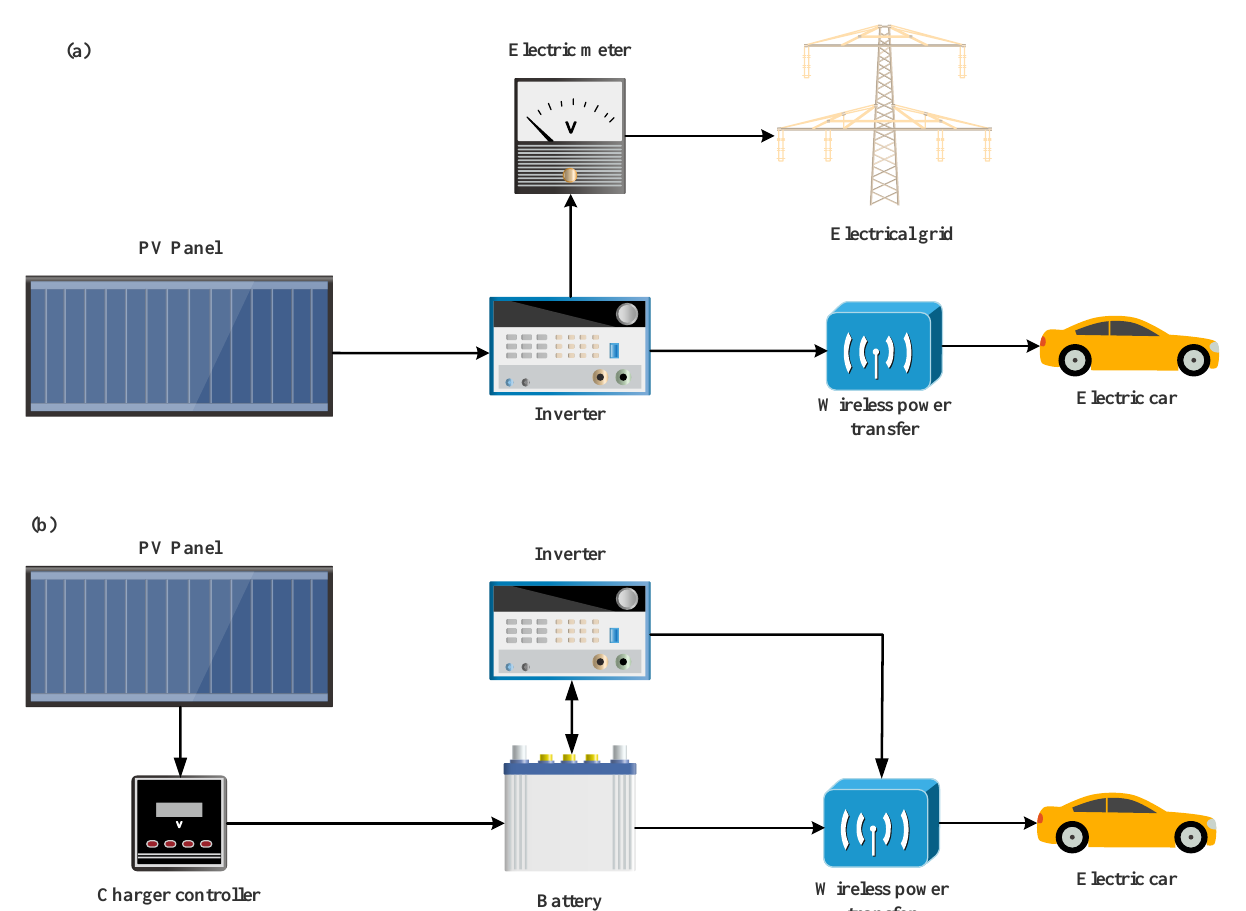
Figure 2. Overview of a grid-connected photovoltaic system ( a ) and off-grid system ( b ).